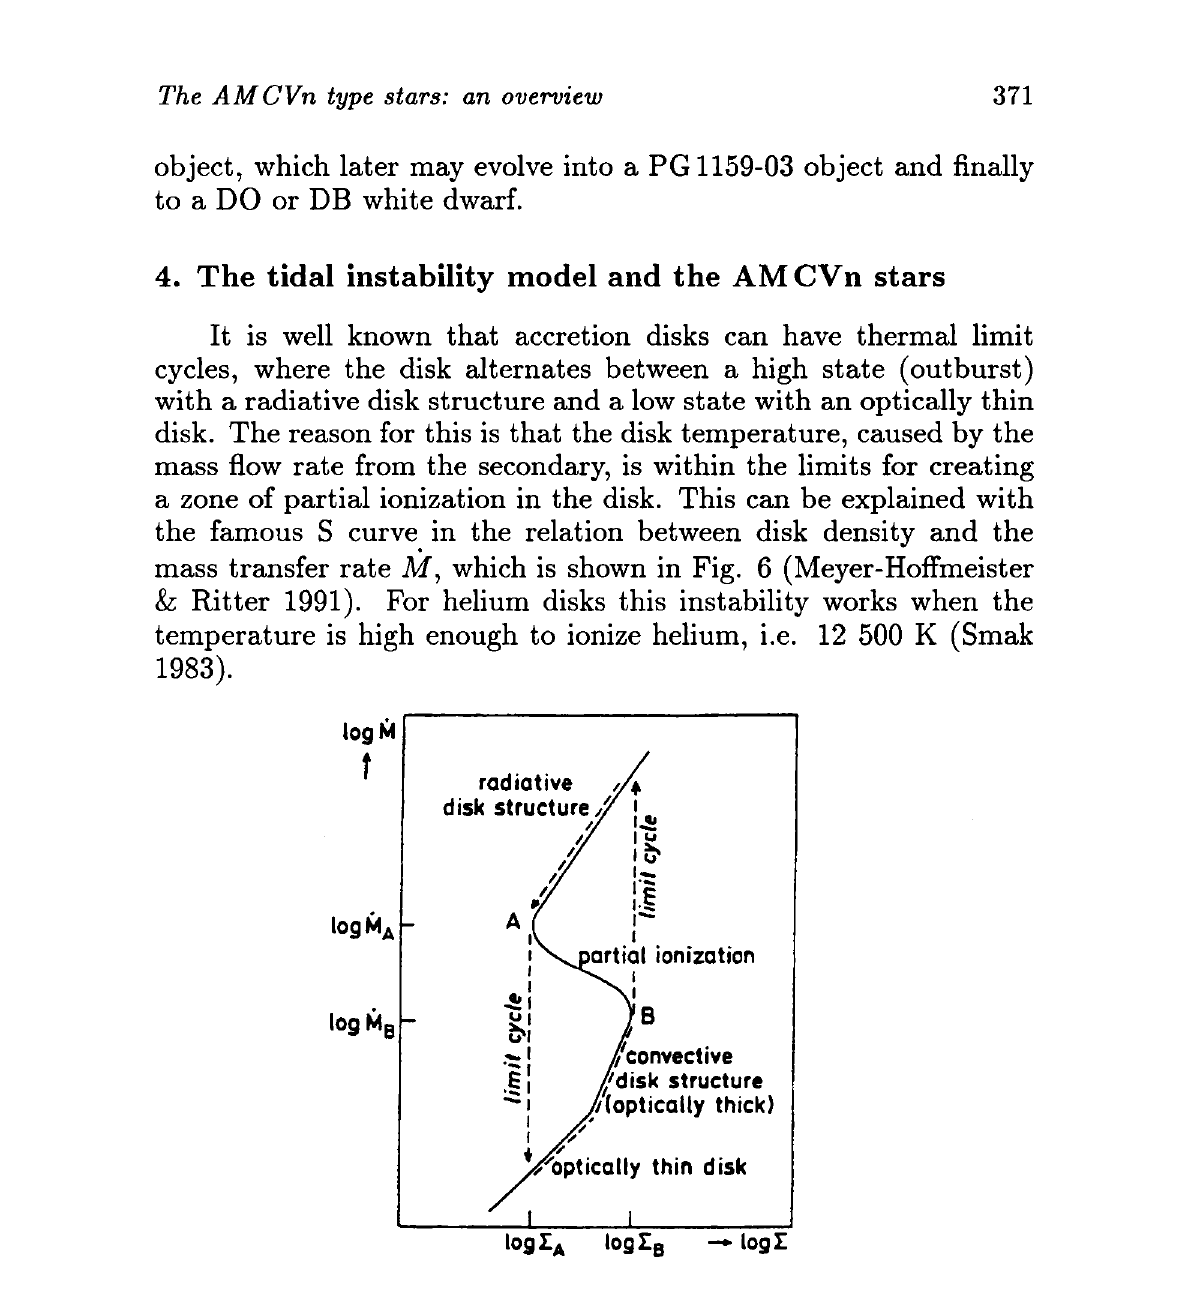
Fig. 6. Scheme of the mass transfer rate versus density relation for accretion disks. The limit cycle between hot and cool states is indicated. From Meyer-HofFmeister & Ritter